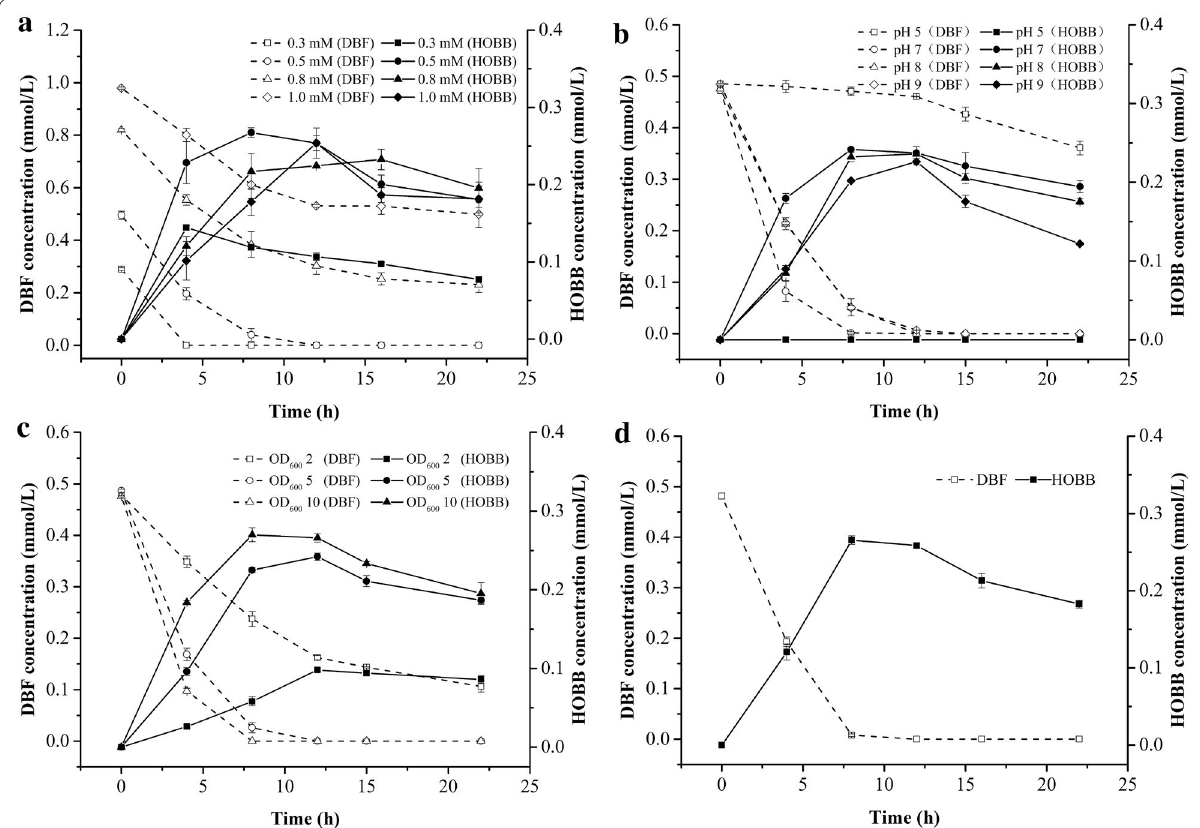
Fig. 3 Trials of biosynthesis conditions. DBF degradation (dotted line) and HOBB accumulation (solid line) were evaluated under different conditions. a Initial DBF concentration. DBF degradation: 0.3-mM DBF (open square), 0.5-mM DBF (open circle), 0.8-mM DBF (open triangle), 1.0-mM DBF (open diamond); HOBB accumulation: 0.3-mM DBF (closed square), 0.5-mM DBF (closed circle), 0.8-mM DBF (closed triangle), and 1.0-mM DBF (closed diamond). b Different pH values. DBF degradation: pH 5 (open square), pH 7 (open circle), pH 8 (open triangle), pH 9 (open diamond); HOBB accumulation: pH 5 (closed square), pH 7 (closed circle), pH 8 (closed triangle), pH 9 (closed diamond). c Cells density. DBF degradation: OD 600 2 (open square), OD 600 5 (open circle), OD 600 10 (open triangle); HOBB accumulation: OD 600 2 (closed square), OD 600 5 (closed circle), and OD 600 10 (closed triangle). d DBF degradation (open square) and HOBB accumulation (closed square) under the best conditions among all trials: OD 600 5, pH 7, and C DBF 0.5 mM in a 10-mL =